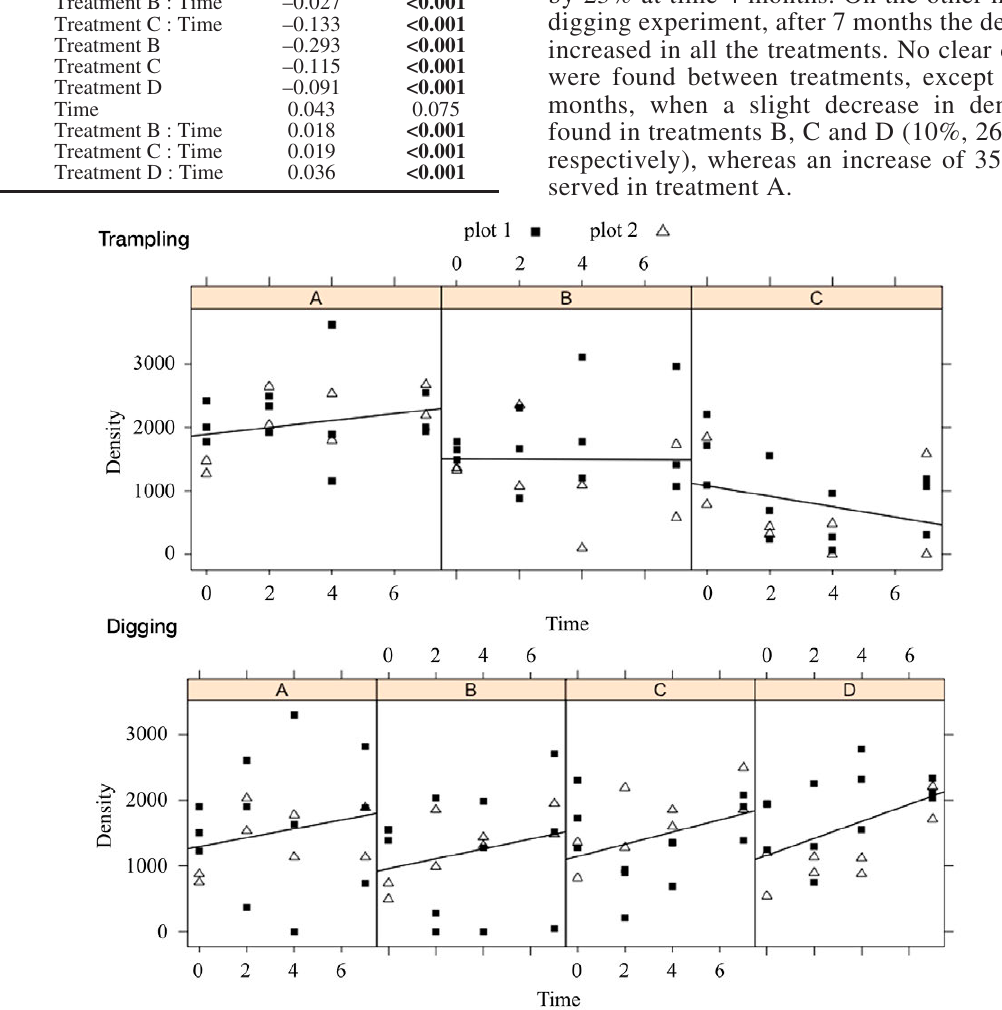
Fig. 5. – Generalized linear mixed model (GLMM) results showing shoot density (shoots m –2 ) of Z. noltei during both field experiments: Trampling (above) and Digging (bottom). Degrees of pressure in the trampling experiment: A, control, no pressure; B, low pressure; C, high pressure. Degrees of pressure in digging experiment: A, control, no pressure; B, low intermittent pressure; C, high intermittent pressure; and D, constant pressure. The lines represent the GLMM fitted to